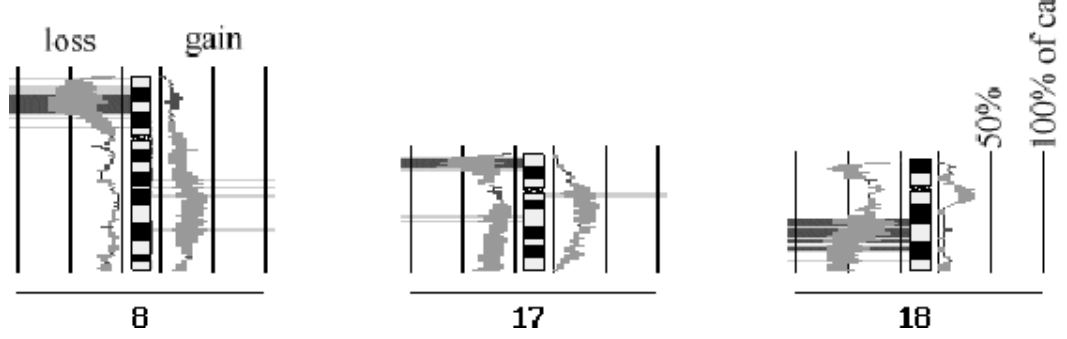
Fig. 8. Differences of chromosomal imbalances between peridiploid (dark gray) and aneuploid tumors (light gray). The aneuploid tumors exhib- ited more losses on 8p21–p22, 17p13 and 18q12–q21 than the peridiploid cases.